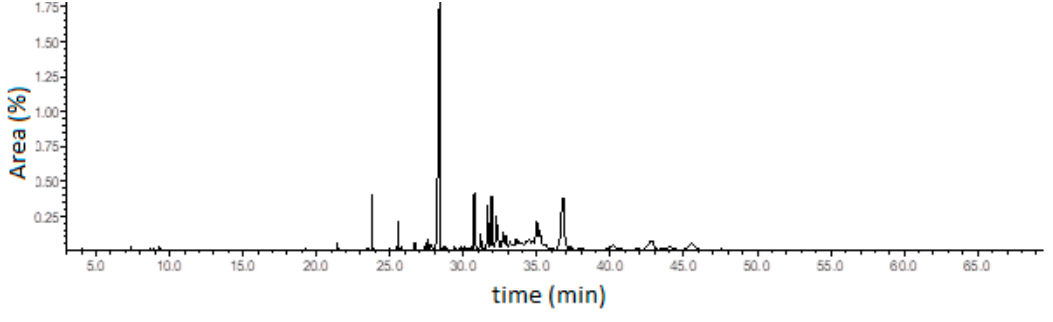
Figure 2. Ion-chromatogram of the E. uniflora oil.